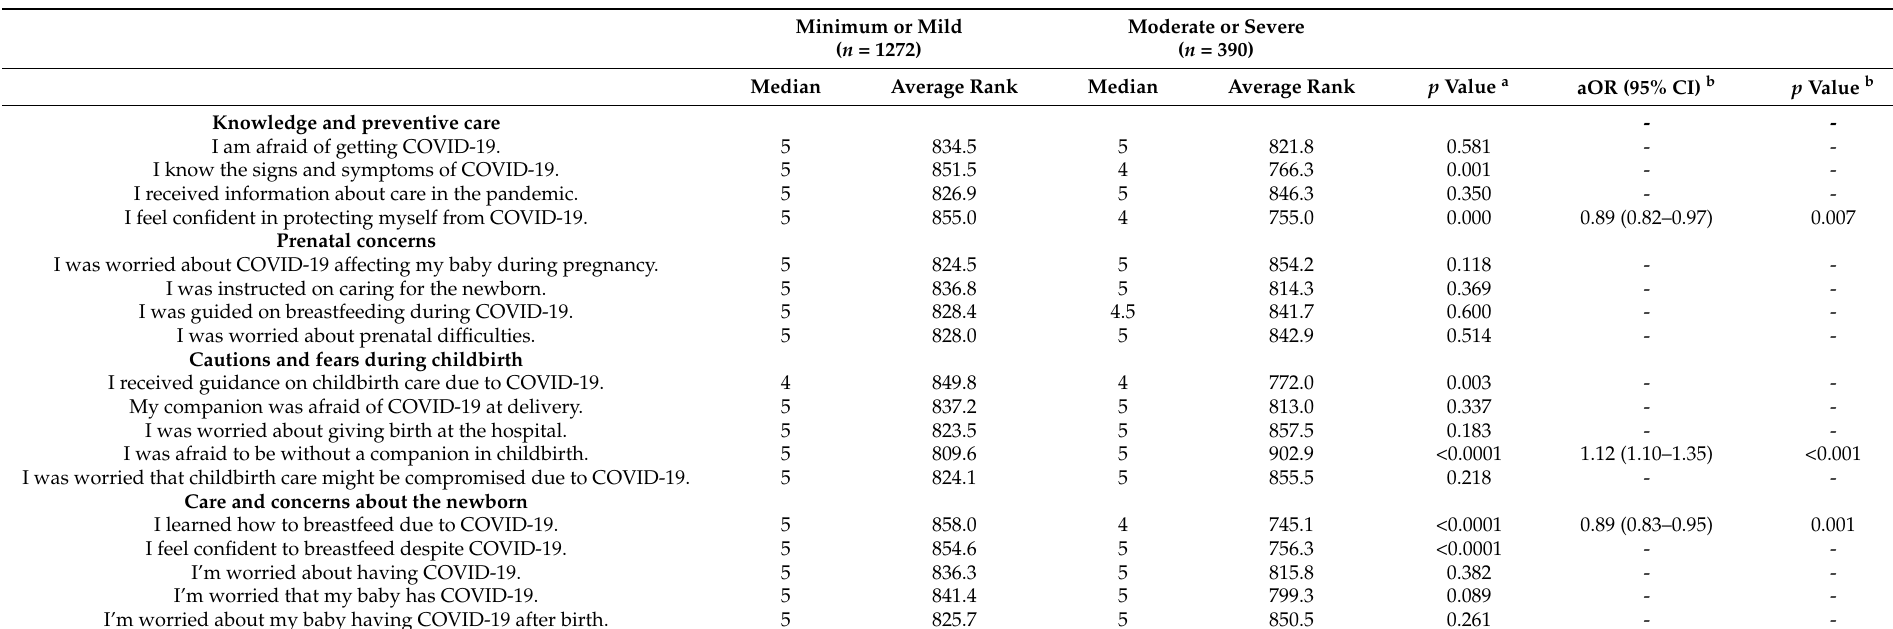
Table 5. Women’s knowledge and concerns about the COVID-19 pandemic associated with moderate or severe maternal anxiety as assessed by the Beck Anxiety Inventory (June–August,